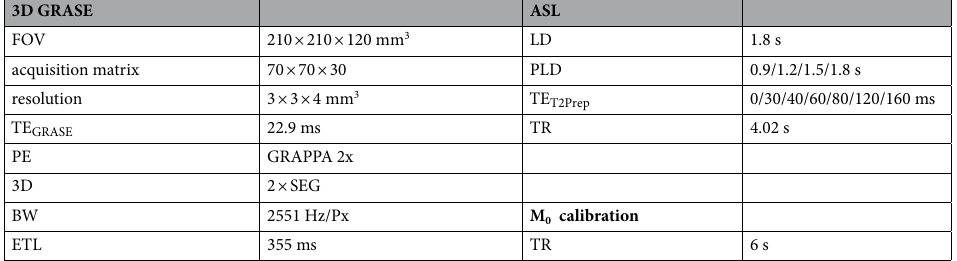
Table 3. Acquisition protocol and ASL parameters. Calibration images, M 0 , were acquired with alternating PE polarity and distortion corrected using FSL’s function topup. M 0 and ASL data were acquired with a twofold segmented (2 × SEG) 3D GRASE readout. Additionally, a structural T 1 -weighted image (resolution (0.8 mm) 3 ) was measured. The scan times were 45:20 min for ASL data (6 MEAS/PLD/ TE T2Prep /SEG/CT pair), 1:15 min for corresponding calibration scans (2 MEAS/PE-direction) and 6:32 min for the T 1 scan resulting in a total scan time of 53:07 min. Abbreviations: ASL, Arterial Spin Labeling; BW, Bandwidth; ETL, Echo Train Length; FOV, Field Of View; PE, Phase Encoding; PLD, Postlabeling Delay; SEG, Segment; TE, Echo Time; TR, Repetition Time.